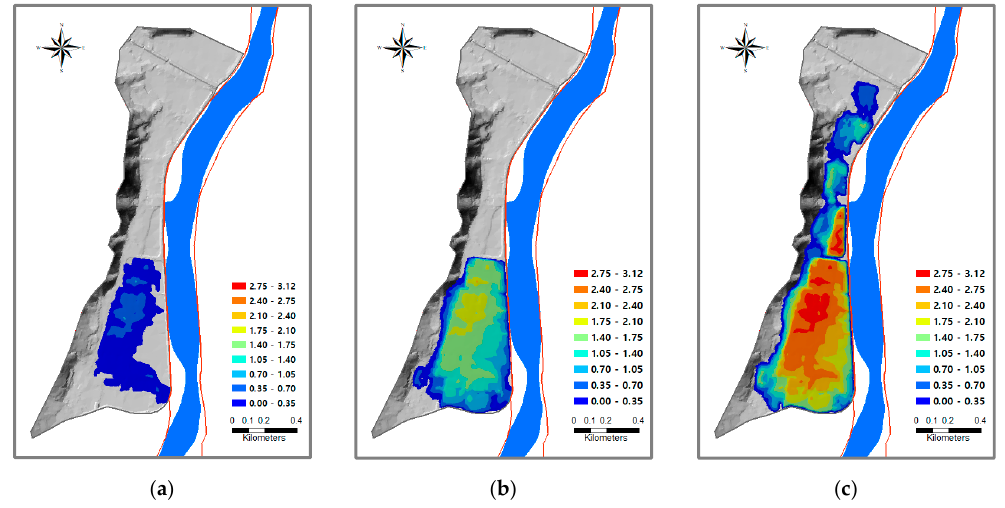
Figure 10. Maximum flood depths for Levee #1 failure case, ( a ) LV1-1, ( b ) LV1-6, ( c ) LV1-9.